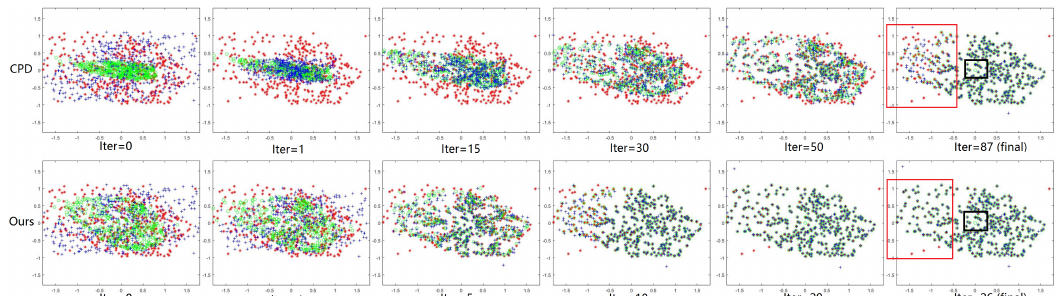
Figure 7. Demonstration of the advantage of the MGMM. Red ∗ : the target feature point set X . Green ◦ : the estimated corresponding point set X ∗ . Blue + : the source feature point set T ( Y ) . Upper row and lower row: registration process of CPD and our method. X and Y are extracted from a remote sensing image pair.